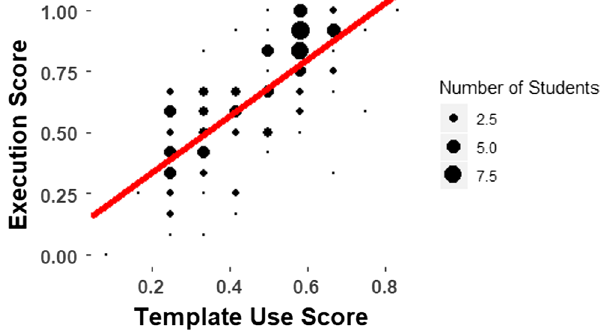
FIG. 3. Scatter plot of execution scores (TA-assigned grades) versus template use scores (how closely students followed the problem solving template) for the Atwood machine problem. The red line is the ordinary least squares linear fit to the data.